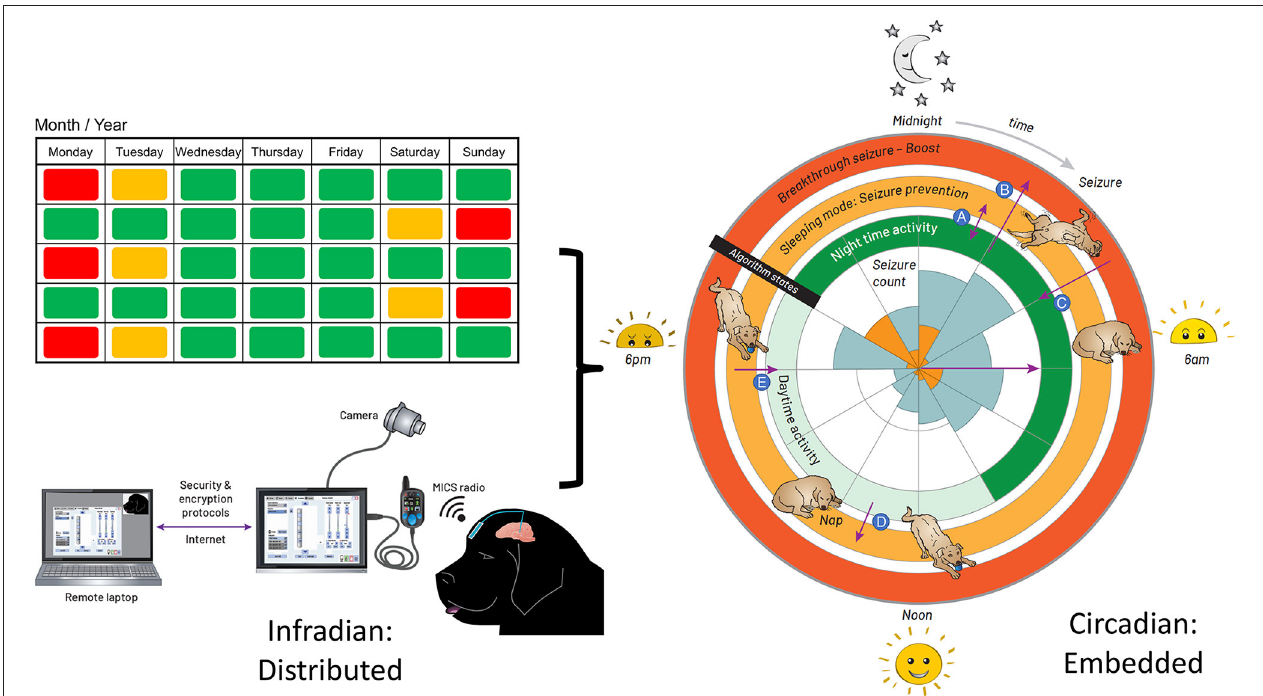
FIGURE 3 | Integrated Circadian-Adaptive Mode Algorithm Strategy. Illustration of the algorithm timing strategy. Left: extended time (e.g., 2-week infradian) updates are provided over an encrypted internet link with a local password-protected application running on a surface tablet via the patient controller. The USB connector between the patient programmer and tablet is for in-clinic programming. Research subjects use the handheld controller for at-home recharge and manual adjustments. Right: the embedded algorithm illustrated with a rose plot. The inner circle represents the seizure count from the diary, kept by the carer, up to the date of DBS activation; the orange tiling is the timing of first seizure onset, while the blue account for all seizures in a cluster. The inner ring of stimulation is the default state when the dog is active. When the accelerometer detects an inactive state for 4 min, the algorithm transitions to the middle ring of stimulation for the sleeping mode . The outer ring is the boost mode for breakthrough seizures. (A) going in and out of sleep during the night, while in night-time mode, the stimulation switches from night-time to the sleeping mode and vice versa . (B) suffering a seizure during the default mode, the carer taps on the site of the implant to trigger the boost mode.